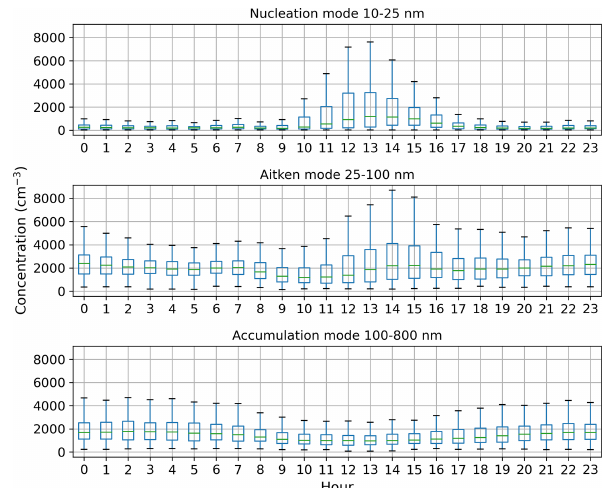
Figure 5. Box-and-whisker plots for hourly median concentra- tion values (cm − 3 ) of different aerosol particle modes. The central line (green) in each box indicates the median, and the bottom and top lines of the boxes indicate the 25th and 75th percentiles. The whiskers mark the most extreme data points that are not considered to be outliers (within a range of 1 . 5 × interquartile range from the edges of the